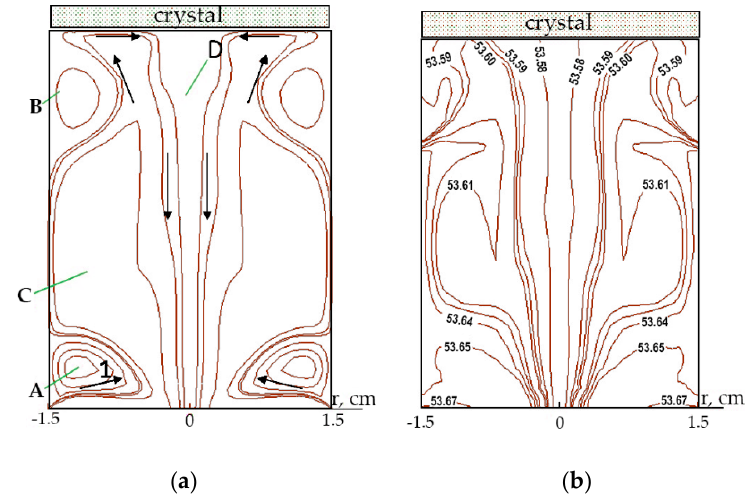
Figure 5. Peripheral solution supply: ( a ) Streamlines of laminar flow; ( b ) KCSH concentration isolines (g/1000 g H 2 O) in the meridional plane at inflow velocity V = 55 cm/s. The inward flow (1) streams up forming vortex meridional swirls (A) and (B). Then after flowing the crystal it flows down through the vortex swirl (C) and the central outflow (D). As the velocity increases from 10 cm/s to 55 cm/sm the enhancement of the vortex swirl (A) weakens an effect of the swirl (B) near the crystal surface. At the same time, the swirl size (C) increases, and the area of the central outflow (D) expands.